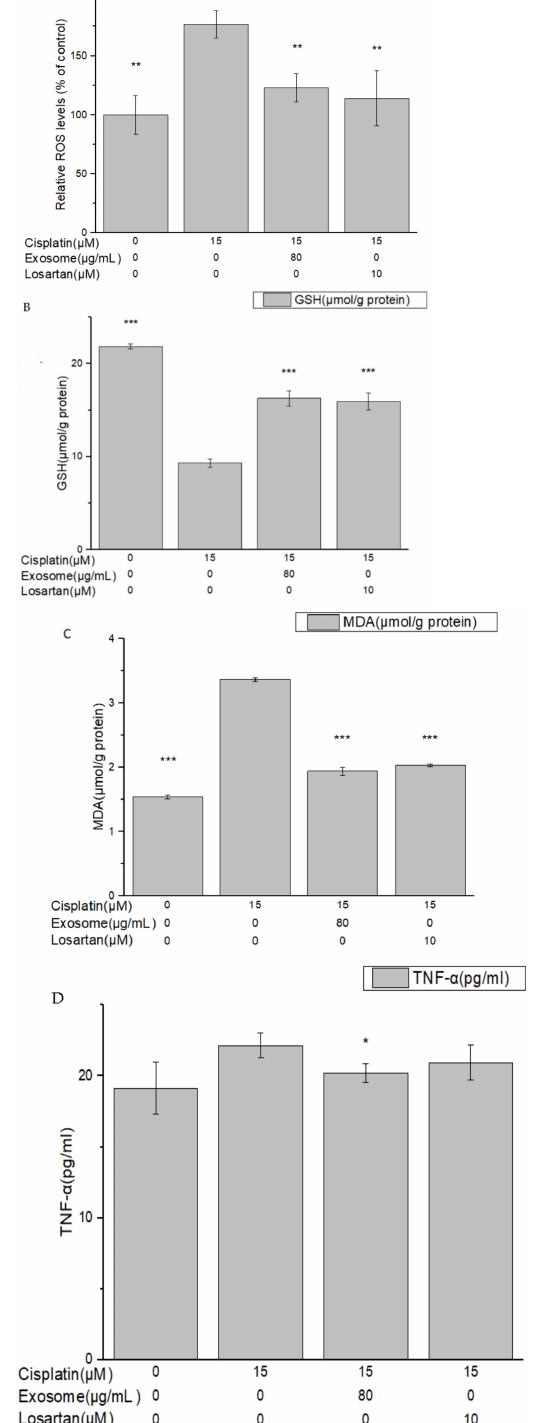
Figure 5. ROS expression ( A ), GSH levels ( B ), MDA levels ( C ) and TNF- α levels ( D ) in cisplatin- treated NRK-52E cells after pretreatment with SCAP-ex or losartan. Values are expressed as mean ± SD ( n = 3), * p < 0.05; ** p < 0.01; *** p < 0.001 for compared with cisplatin treated group. GSH, glutathione; MDA, malondialdehyde; ROS, reactive oxygen species; SCAPs, stem cells from the apical papilla; SCAP-ex, SCAP-derived exosomes; TNF- α , tumor necrosis